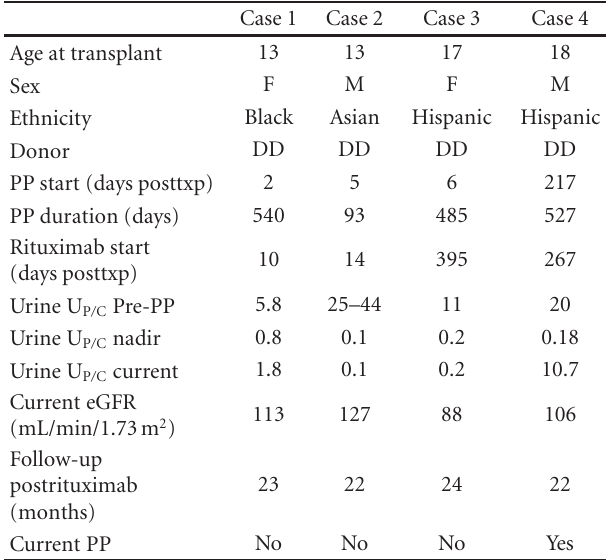
Table 1: Clinical features of cases of pediatric recurrent